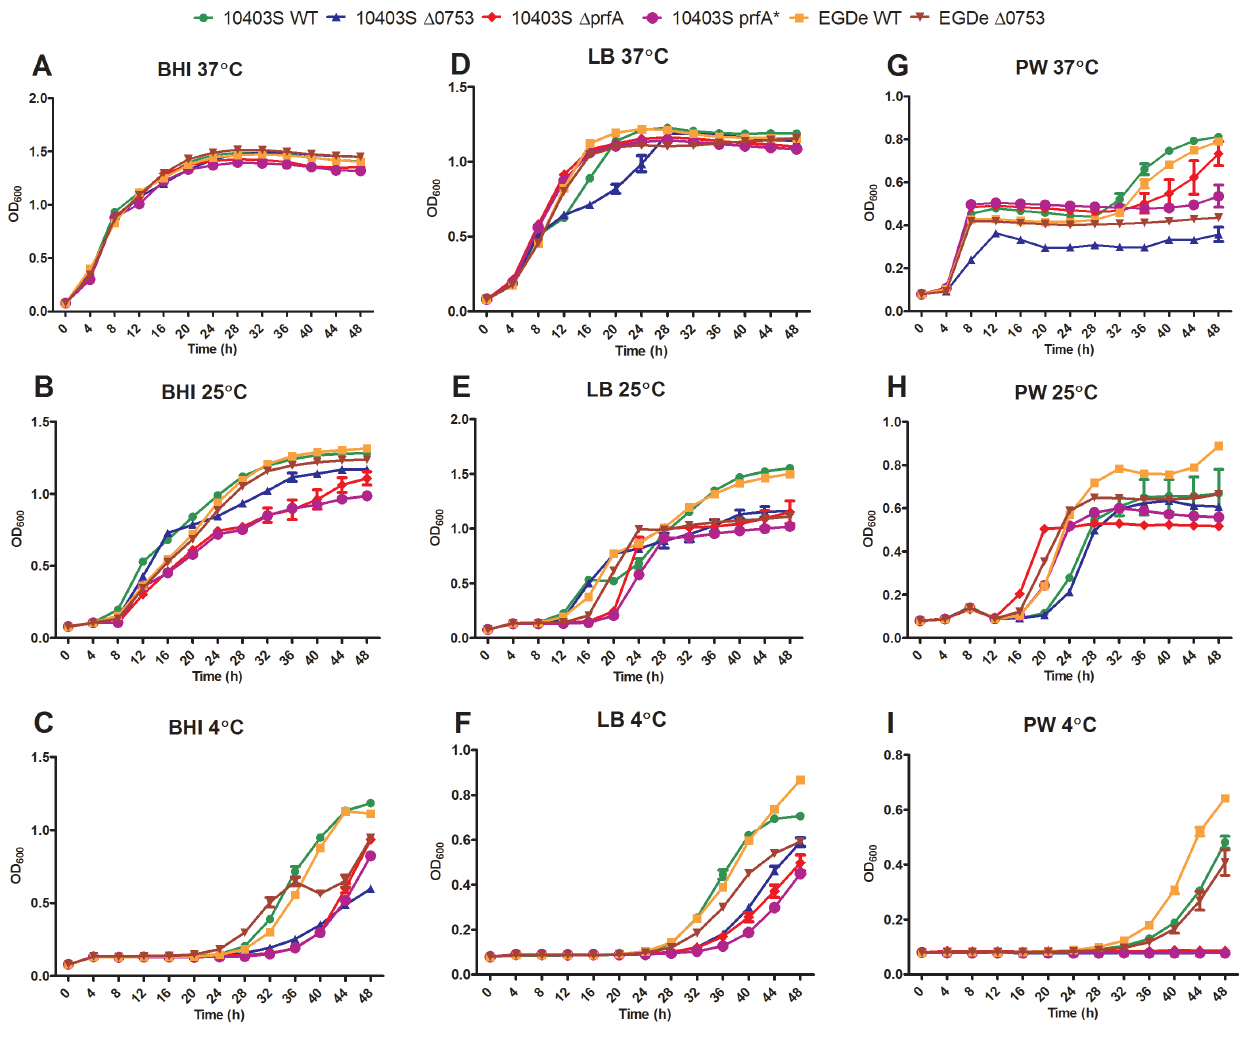
Figure 1. Growth of L.monocytogenes strains in broth culture. Standard deviations represent three independent experiments.